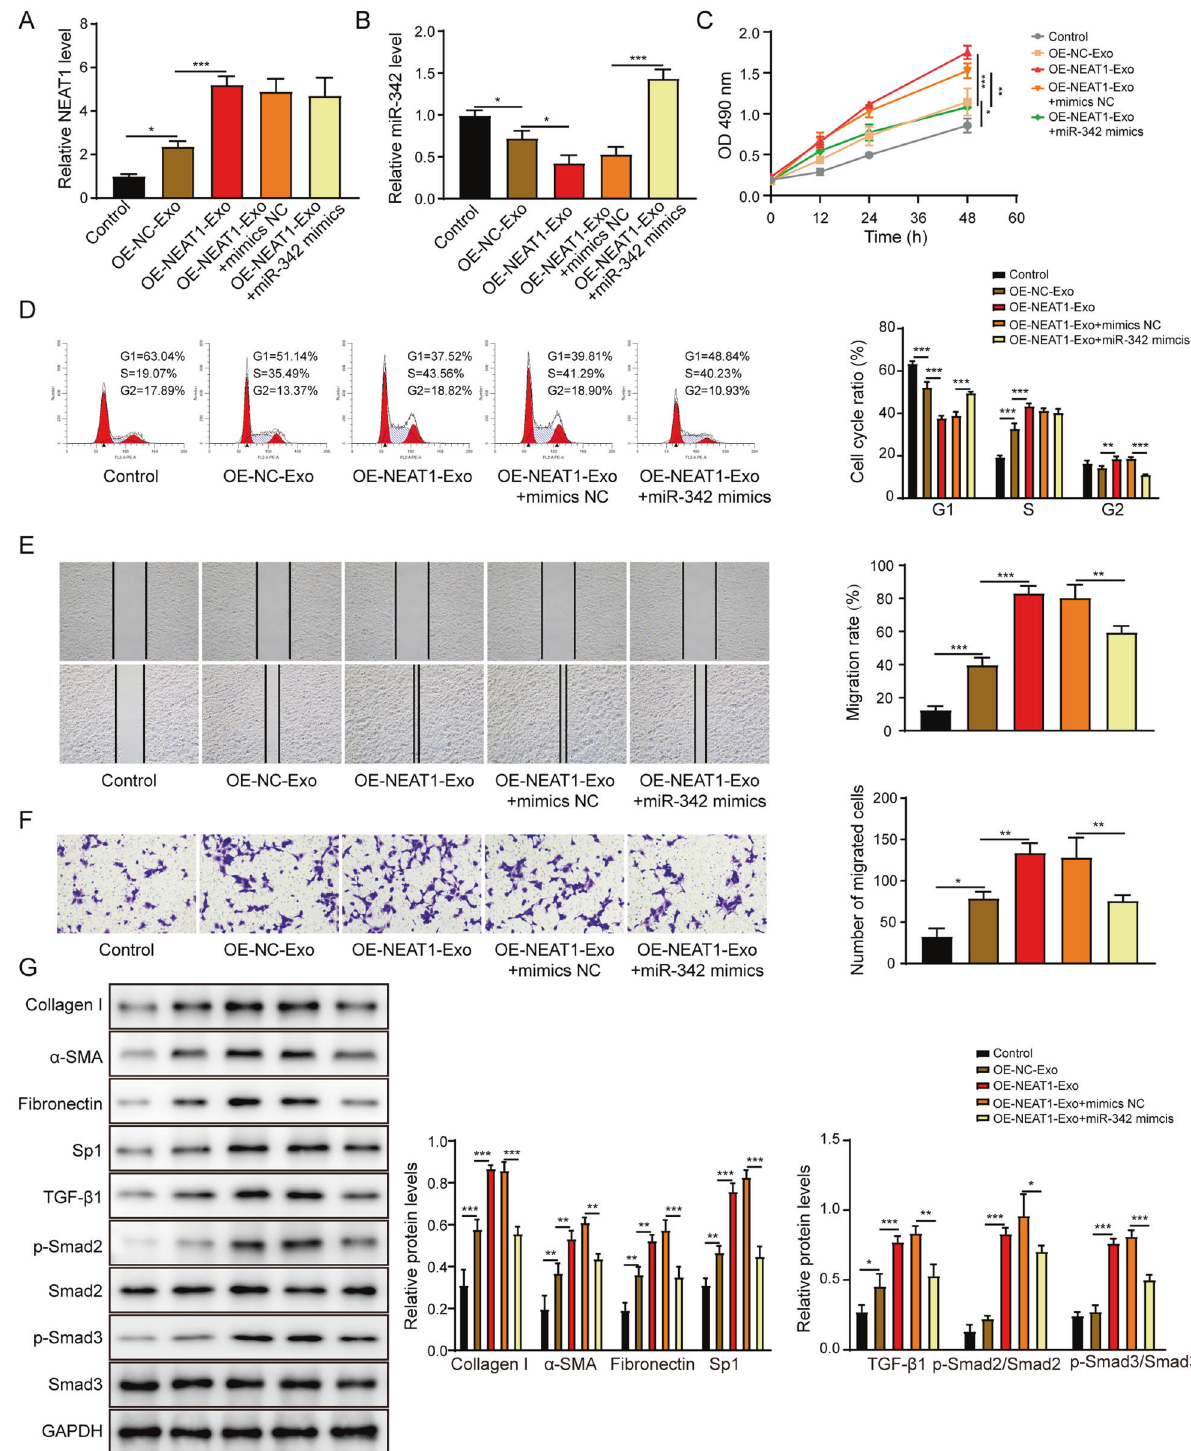
Fig. 6 NEAT1 overexpressed exosomes enhance the activation of HSCs by inhibiting miR-342. A , B The NEAT1 ( A ) and miR-342 ( B ) expression levels in LX-2 cells were assessed via qRT-PCR. C The LX-2 cell proliferation was examined by the CCK-8 assay. D The cell cycle of the LX-2 was examined by the fl ow cytometry. E , F The migration of LX-2 was determined by the scratch assay ( E ) and the transwell assay ( F ). G The protein levels of collagen I, α -SMA, fi bronectin, Sp1, TGF- β 1, p-Smad2, Smad2, p-Smad3 and Smad3 were measured by western blot. * p < 0.05; ** p < 0.01; *** p < 0.001.